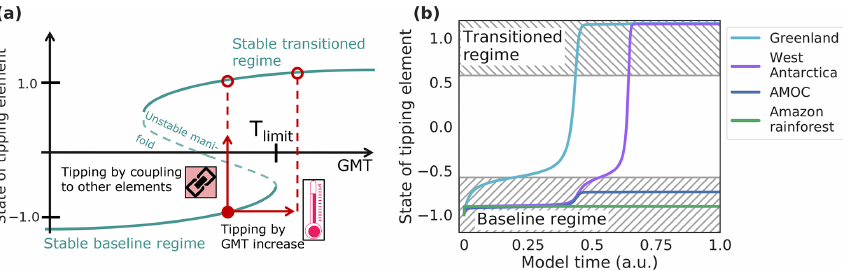
Figure 2. Schematic overview of the generalised tipping element and time series of a tipping cascade. (a) Exemplary bifurcation diagram of a tipping element with two stable regimes: the lower state indicates the stable baseline regime, and the upper state indicates the stable transitioned regime. For the Greenland Ice Sheet, for instance, these correspond to its pre-industrial, almost completely ice-covered state (stable baseline regime) and an almost ice-free state (stable transitioned regime), as can be expected in the long term for higher warming scenarios (Robinson et al., 2012). There are two ways that a tipping element can transgress its critical threshold ( unstable manifold ) and move into the transitioned state: an increase in the global mean surface temperature or via interactions with other climate components. In both cases, the tipping element converges to the stable transitioned regime indicated by the red hollow circles. (b) Exemplary time series showing a tipping cascade of two elements. Here, Greenland transgresses its critical temperature ( T limit , Greenland ) first, i.e. would become ice-free. Through its interaction with the West Antarctic Ice Sheet, the West Antarctic Ice Sheet then transgresses the unstable manifold in the vertical direction (following the path of the red upward-directed arrow in panel a ). This example is based on a scenario with global mean surface temperature increase of 1.6 ◦ C above pre-industrial levels and an interaction strength d = 0 . 16 (see also Fig.